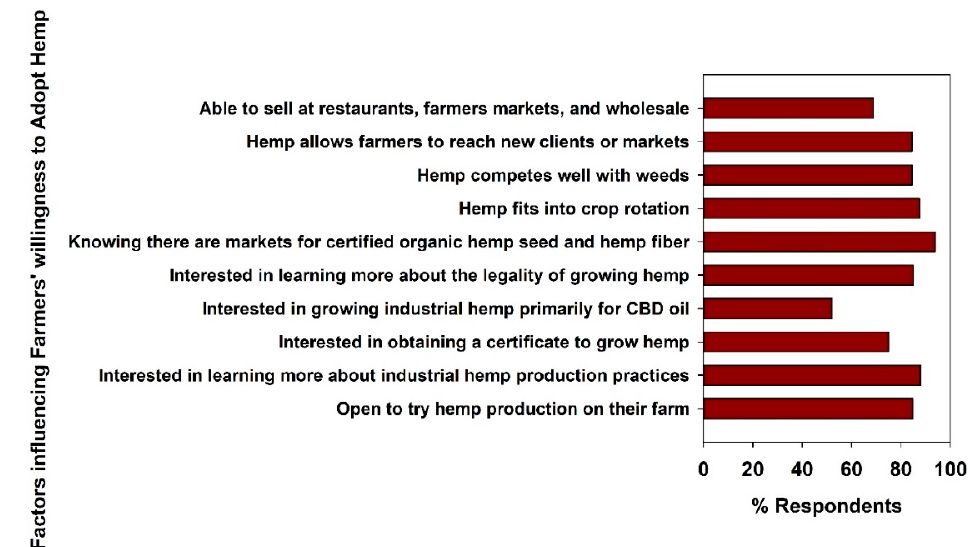
Figure 1. Factors influencing farmers’ willingness to adopt hemp through a survey study conducted in North Carolina. Adapted from [41].